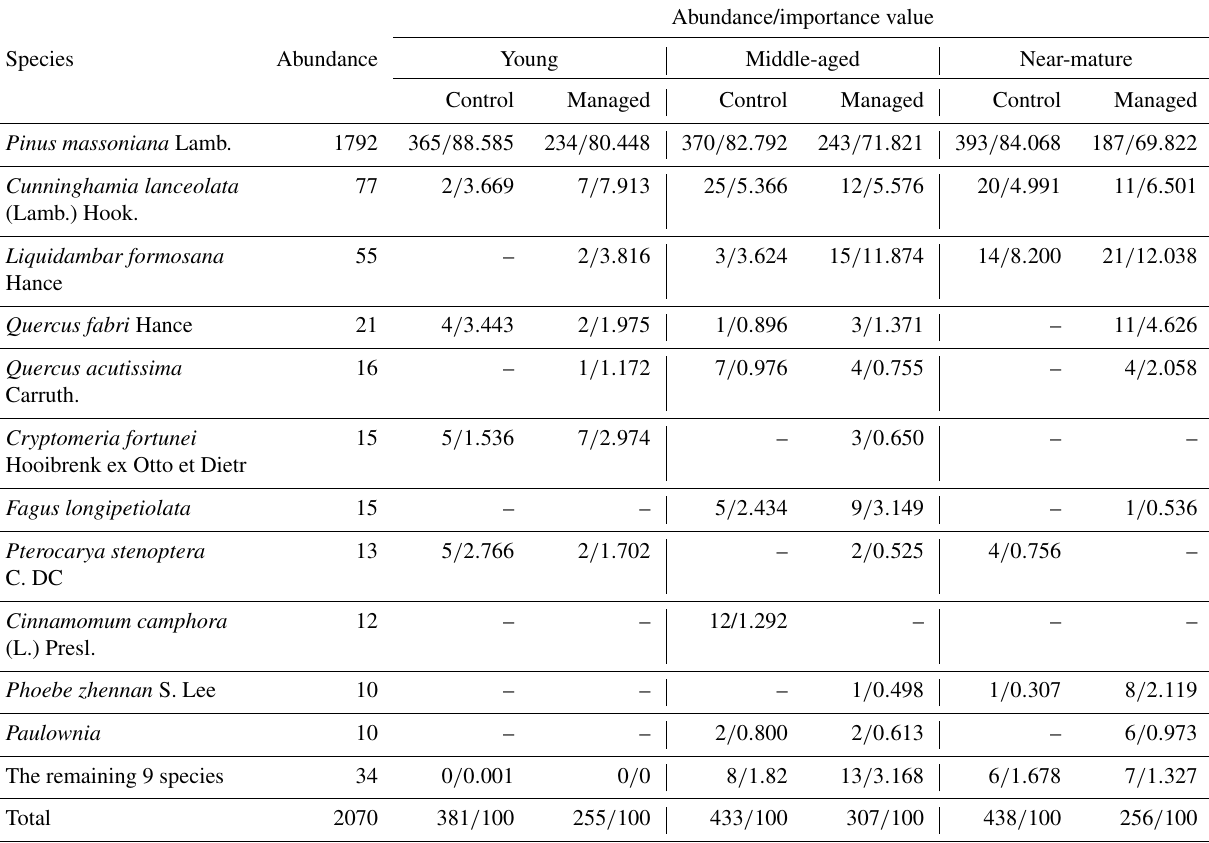
Table 2. Composition and importance value index of tree species under close-to-nature management.